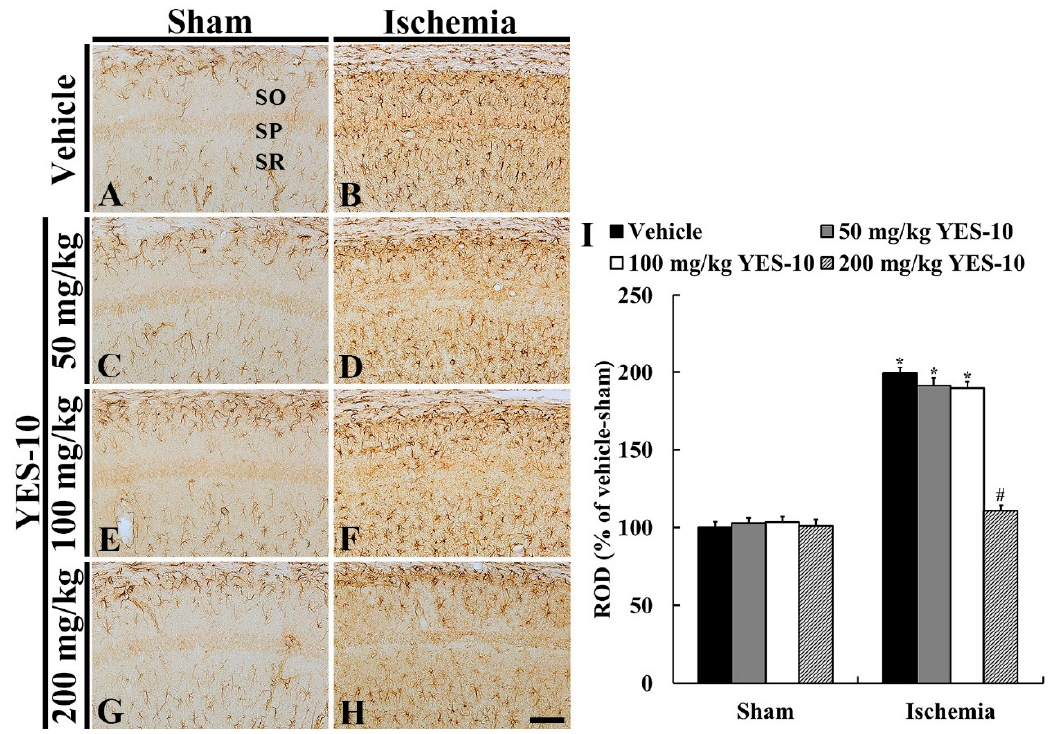
Figure 4. Immunohistochemistry for GFAP in the CA1 field of the vehicle/sham ( A ), 50 mg/kg YES-10/sham ( C ), 100 mg/kg YES-10/sham ( E ), 200 mg/kg YES-10/sham ( G ), vehicle/ischemia ( B ), 50 mg/kg YES-10/ischemia ( D ), 100 mg/kg YES-10/ischemia ( F ) and 200 mg/kg YES-10/ischemia ( H ) groups at 5 days post-ischemia. GFAP immunoreactive astrocytes are very similar in all the sham groups. In the vehicle/ischemia group, GFAP immunoreactive astrocytes are hypertrophied. In the 50 and 100 mg/kg YES-10/ischemia groups, GFAP immunoreactive astrocytes are similar to those in the vehicle/ischemia group. However, in the 200 mg/kg YES-10/ischemia group, the cytoplasm of GFAP immunoreactive astrocytes is lesser hypertrophied than that in the vehicle/ischemia group. Scale bar = 100 μ m. (I) ROD as % of GFAP immunoreactive structures in the CA1 field at 5 days post-ischemia (n = 7 in each group, * P < 0.05 versus vehicle/sham group, # P < 0.05 versus vehicle/ischemia group). The bars indicate the means ± SEM.